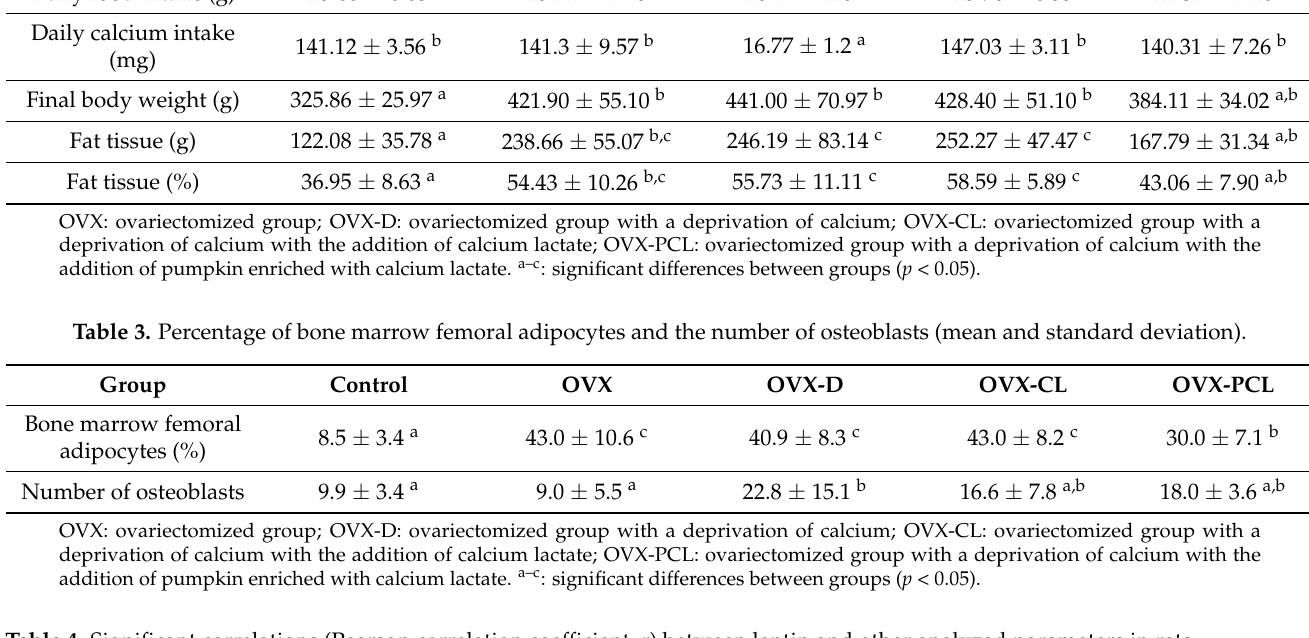
Table 4. Significant correlations (Pearson correlation coefficient, r) between leptin and other analyzed parameters in rats.